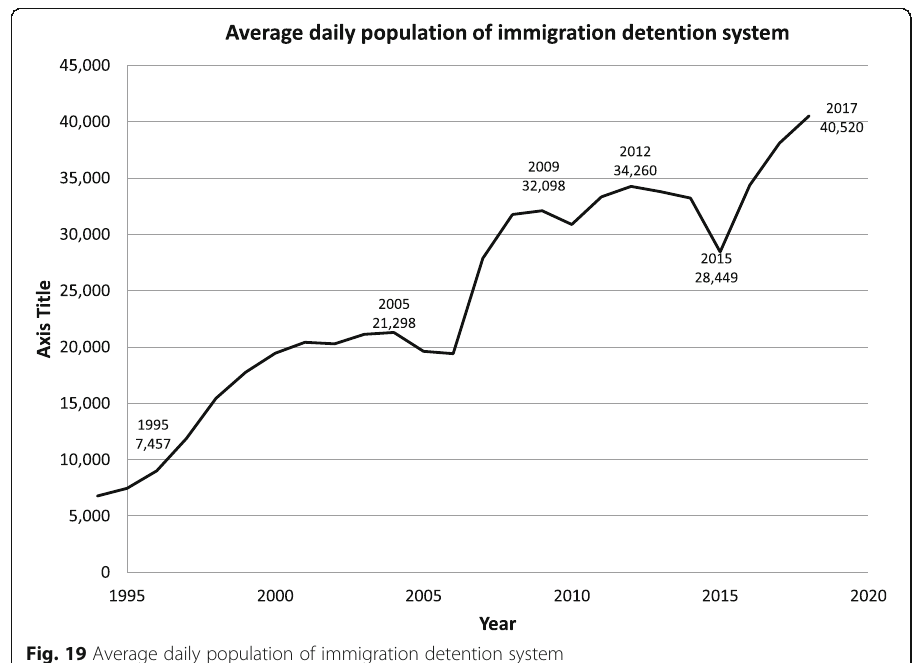
Fig. 19 Average daily population of immigration detention